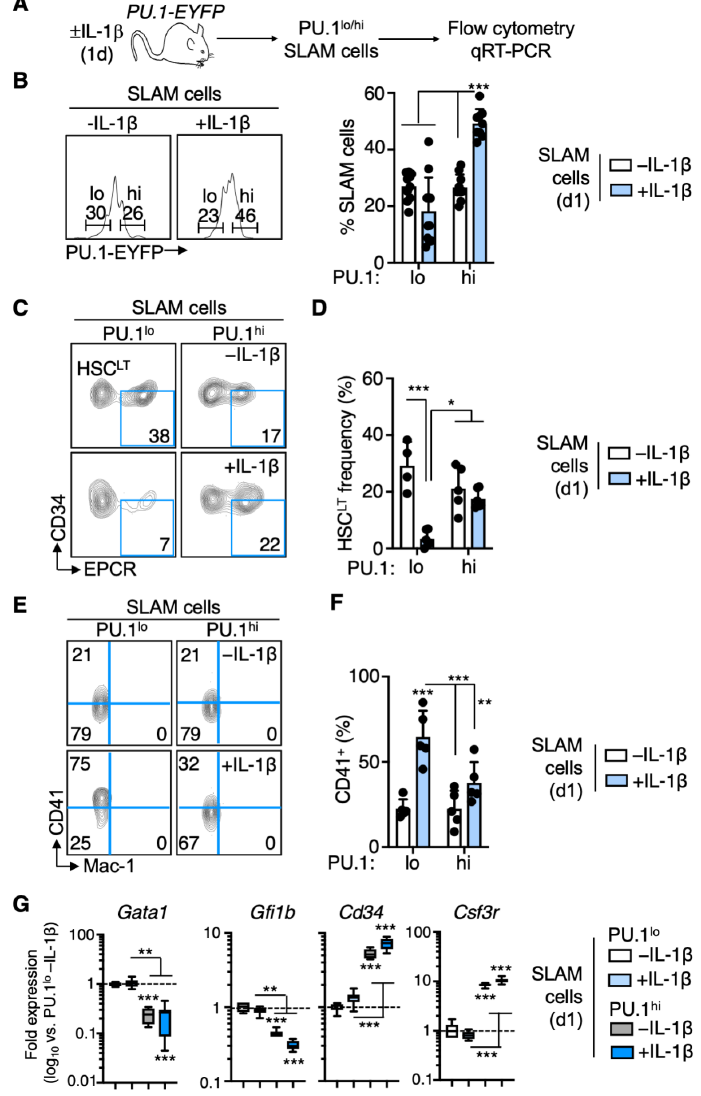
Figure 4. Rapid PU.1 induction and expansion of lineage-primed SLAM cells in response to IL-1 β . ( A ) Experimental design for analysis of PU.1-EYFP mice treated for 1 d IL-1 ( n = 6/grp). ( B ) Repre- sentative FACS plot (left) and summary data (right) showing frequency of PU.1 lo and PU.1 hi SLAM cells in PU.1-EYFP mice treated for 20 d IL-1 β ( n = 8–10/grp). Individual values are shown, and bars represent mean values. Data are compiled from two independent experiments. ( C ) Representative FACS plot showing phenotypic HSCLT frequencies within the SLAM gate in PU.1-EYFP mice treated for 20 d IL-1 β . ( D ) Summary data showing phenotypic HSCLT frequency within the SLAM gate of PU.1-EYFP mice treated for 20 d IL-1 β ( n = 4–6/grp). Individual values are shown, and bars represent mean values. Data are compiled from two independent experiments. ( E ) Representative FACS plot showing frequencies of CD41+ and Mac-1+ cells within the SLAM gate in PU.1-EYFP mice treated for 1 d IL-1 β . ( F ) Frequency of CD41+ cells within the SLAM gate of PU.1-EYFP mice treated for 1 d IL-1 β ( n = 5/grp). Individual values are shown, and bars represent mean values. Data are representative of two independent experiments. ( G ) Fluidigm qRT-PCR analysis of genes in PU.1 lo and PU.1 hi SLAM cells from PU.1-EYFP mice treated for 1 d IL-1 β ( n = 8/grp). Data are expressed as log10 fold change versus PU.1 lo -IL-1 β . Box represents upper and lower quartiles with line representing median value. Whiskers represent minimum and maximum values. Data are representative of two independent experiments. Data are shown as means SD. Significance was determined by ANOVA with Tukey’s post-test. * p < 0.05; ** p < 0.01; *** p <